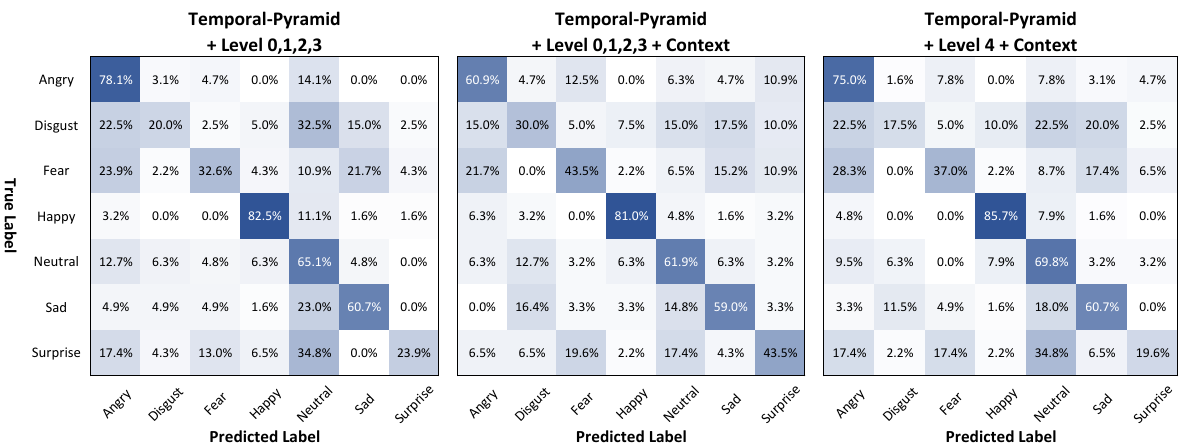
Figure 12. Confusion matrices of Models 6, 9, and 8 (from left to right), which use the temporal-pyramid approach on the AFEW validation